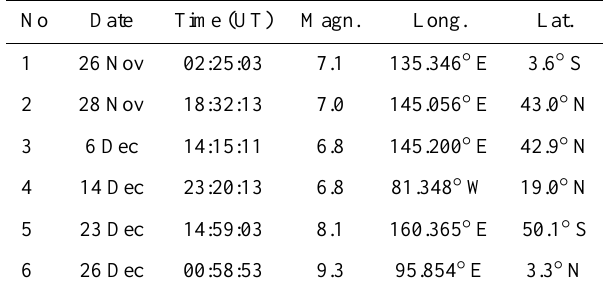
Table 1. Place, date/time, magnitude, Longitude, Latitude of M > 6.8 earthquakes for the time period starting one month before the giant Sumatra-Andaman earthquake until the end of the year 2004, as given in the list of “Significant Earthquakes” of the US Geophysical Survey